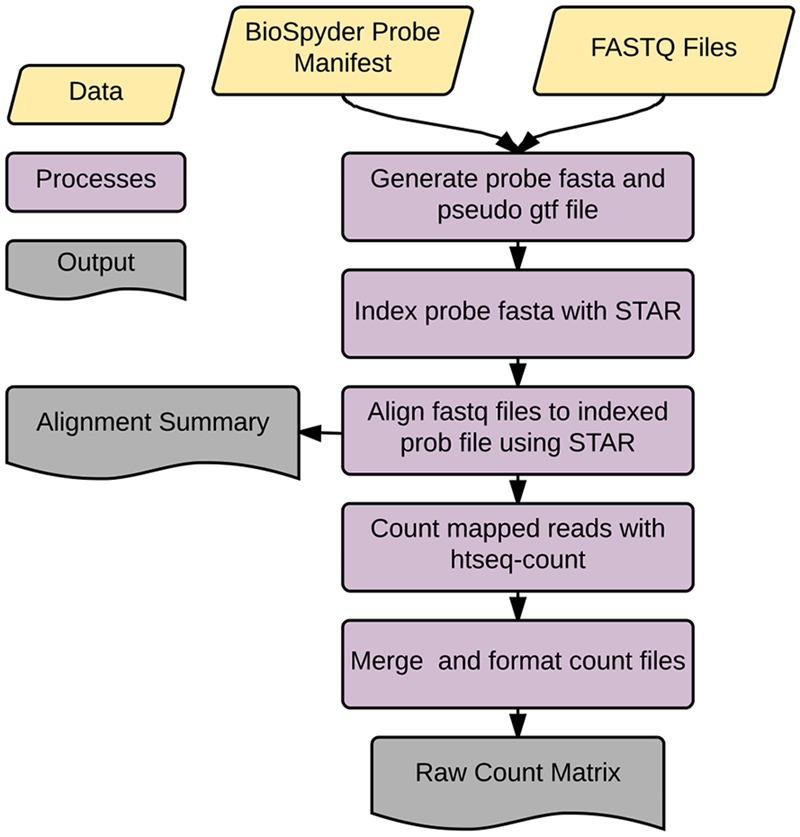
temposeqcount overview. Self-contained and implemented in a Ruffus framework. A directory of fastq files and the probe manifest are the only inputs to generate the count matrix required for the remainder of the pipeline.